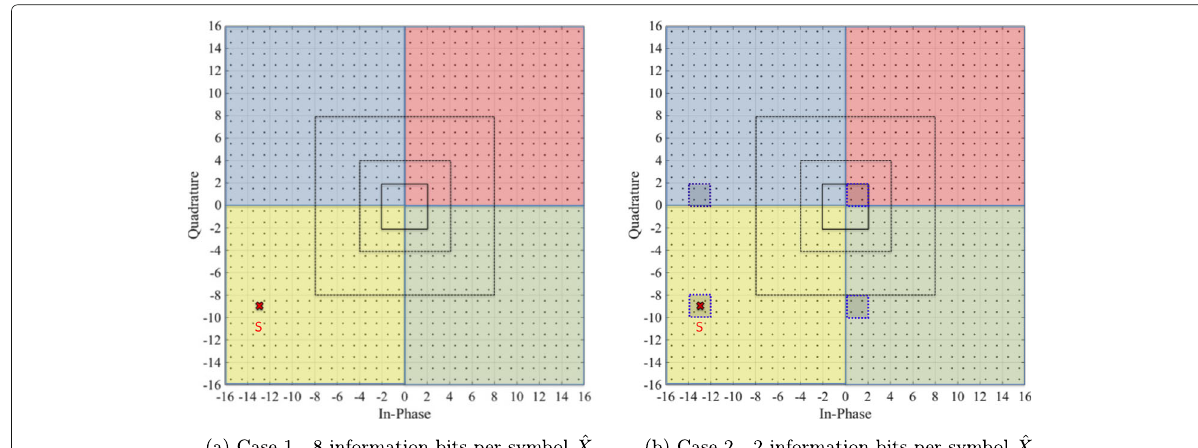
Fig. 8 Shaping region mapping